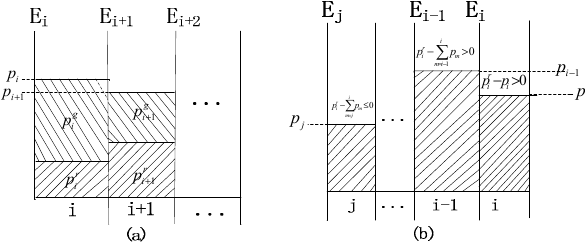
Figure 4. Two types of power allocation model. ( a ) The less renewable energy allocation model; ( b ) The enough renewable energy allocation